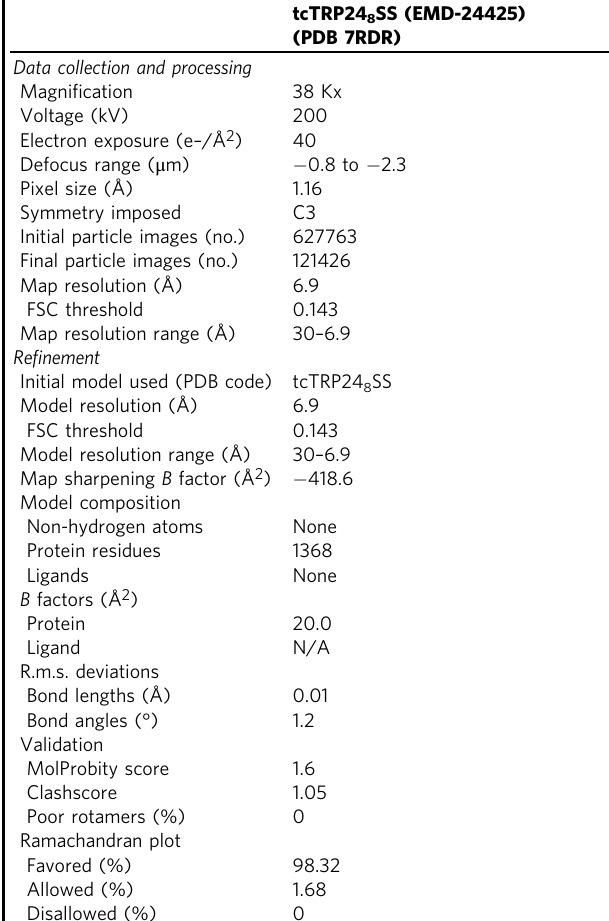
Table 2 Cryo-EM data collection, re fi nement, and validation